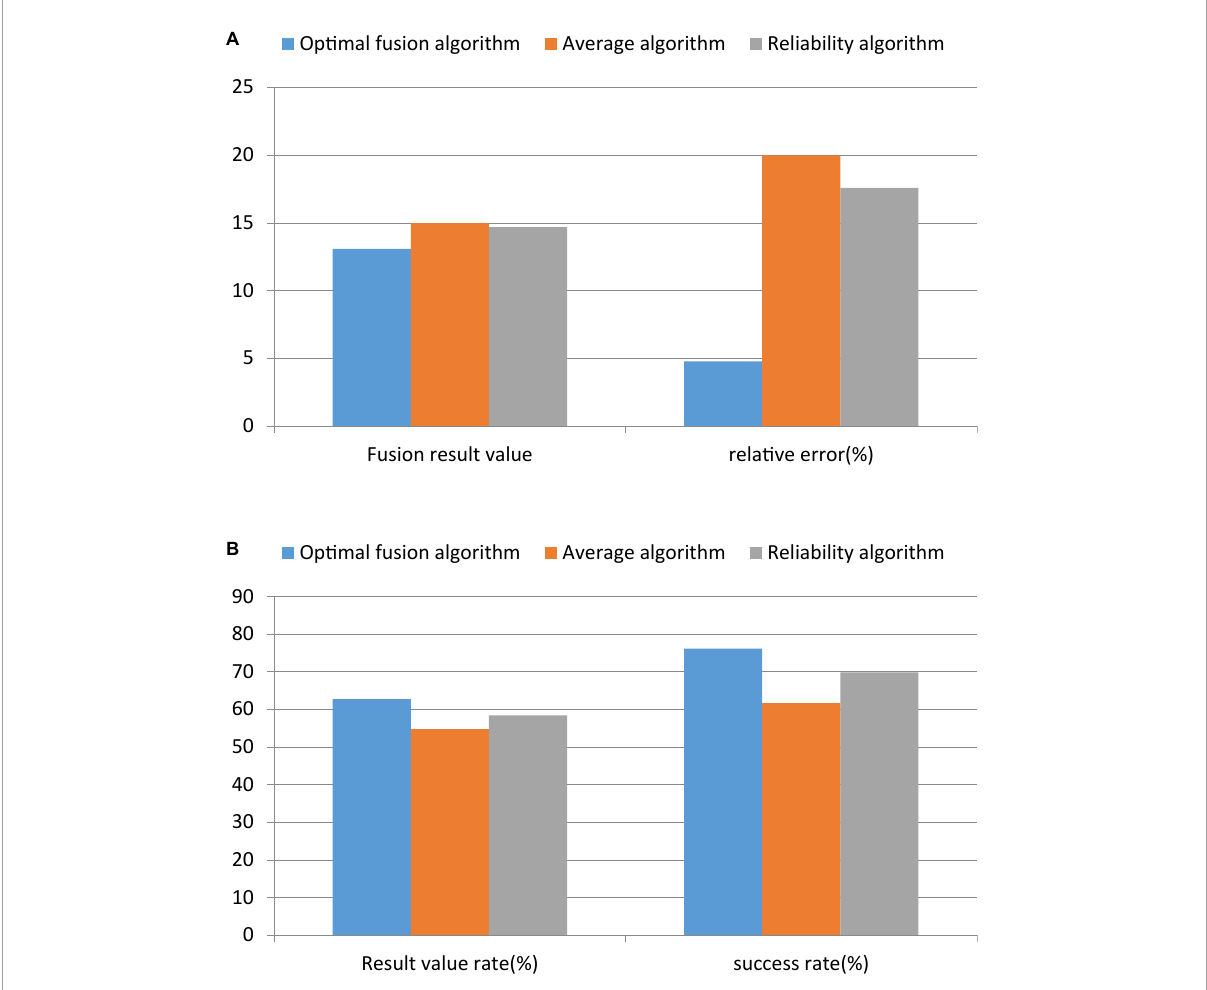
FIGURE11 Comparison of results based on data fusion. (A) Data fusion algorithm calculation results before optimization. (B) Calculation results of the optimized data fusion